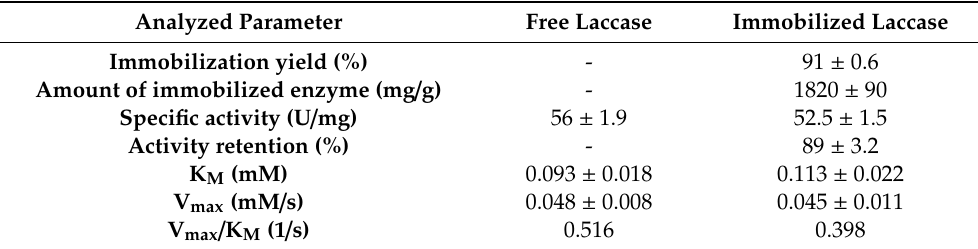
Table 1. Parameters characterizing the immobilization process (amount of the immobilized enzyme, immobilization yield, specific activity and relative activity of free and immobilized laccase, and kinetic parameters of the free and immobilized